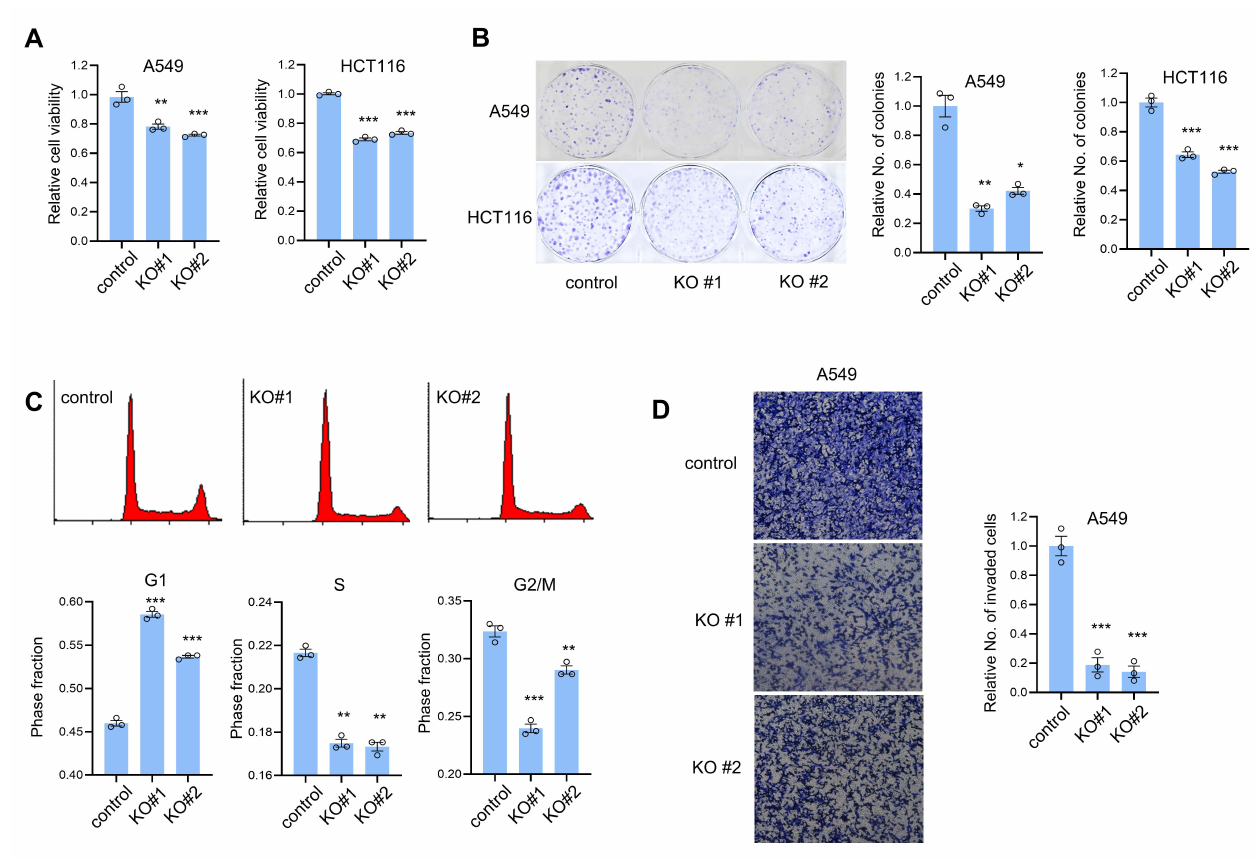
Figure 3. CTRP1 knockout cells show decreased cell proliferation and invasion. ( A ) CTRP1 knockout cells showed decreased cell proliferation. Cell proliferation of control and knockout cells was measured using the 3-(4,5-dimethylthiazol-2-yl)-2,5-diphenyl tetrazolium bromide (MTT) assay. Control vs. knockout cells: ** p < 0.01, *** p < 0.005. ( B ) CTRP1 knockout decreased colony formation. An equal number of cells (1000 cells) were plated onto the wells of a 6-well plate, and the clonogenic assay was performed for 10 d. The number of colonies was counted and is depicted in the graph (bottom panel). Control vs. knockout cells: * p < 0.05, ** p < 0.01, *** p < 0.005. ( C ) CTRP1 knockout cells showed delayed cell cycle progression. Control and CTRP1 knockout cells were analyzed using flow cytometry and the proportion of G1, S, and G2/M cells were calculated. ( D ) An invasion assay showed that CTRP1 knockout resulted in the decreased invasion ability of A549 cells. Control vs. knockout cells: ** p < 0.01, *** p <